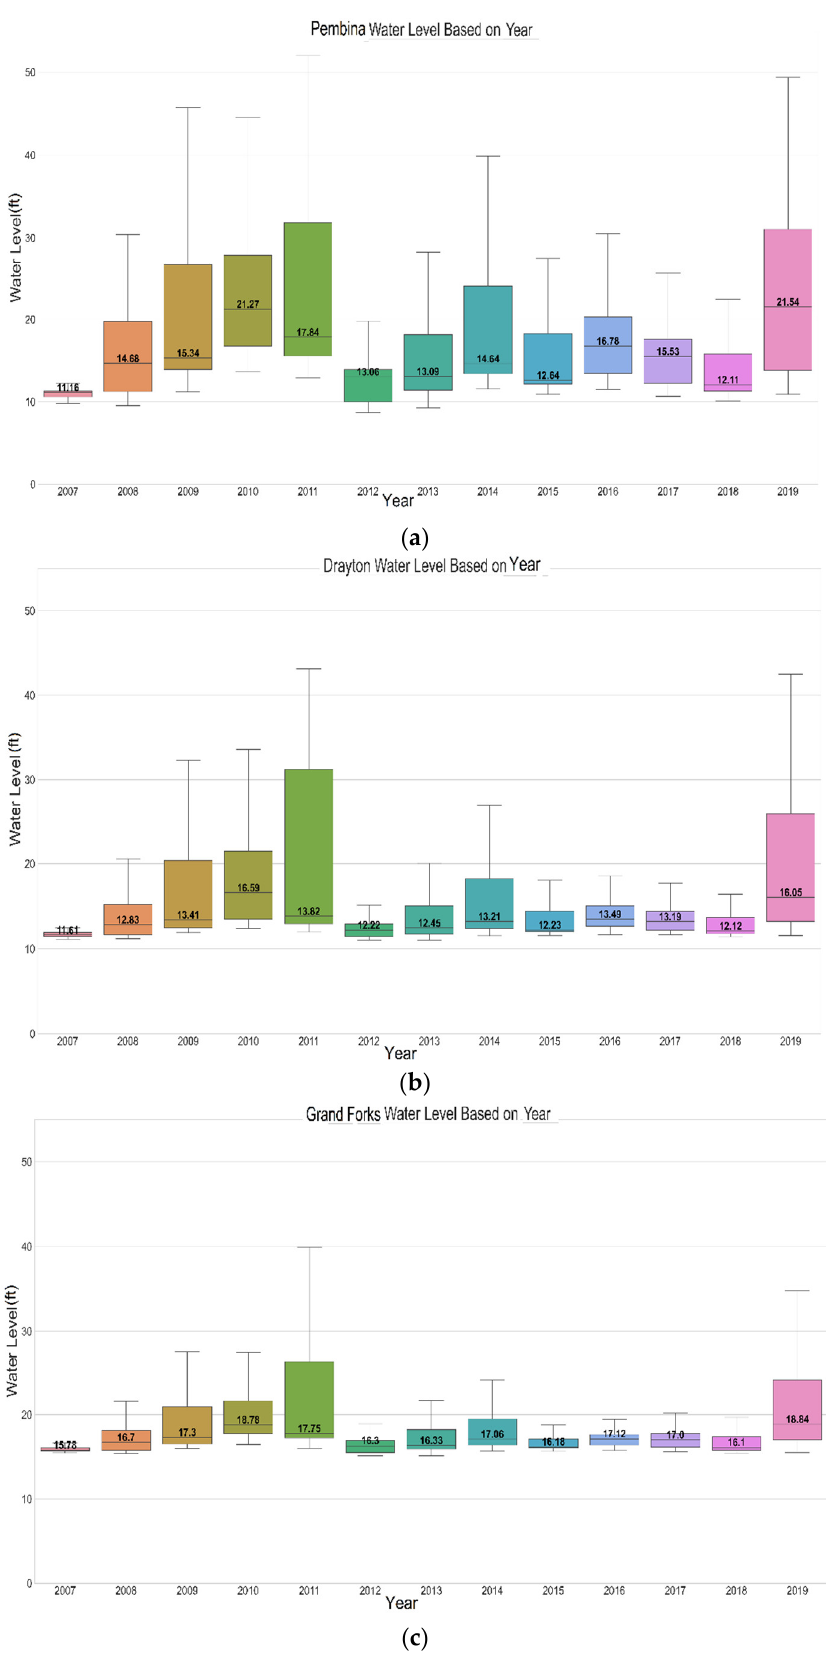
Figure 3. Box and whisker plot of water-level data at three hydrology stations of Red River of the North: ( a ) Pembina, ( b ) Drayton, and ( c ) Grand Forks stations.